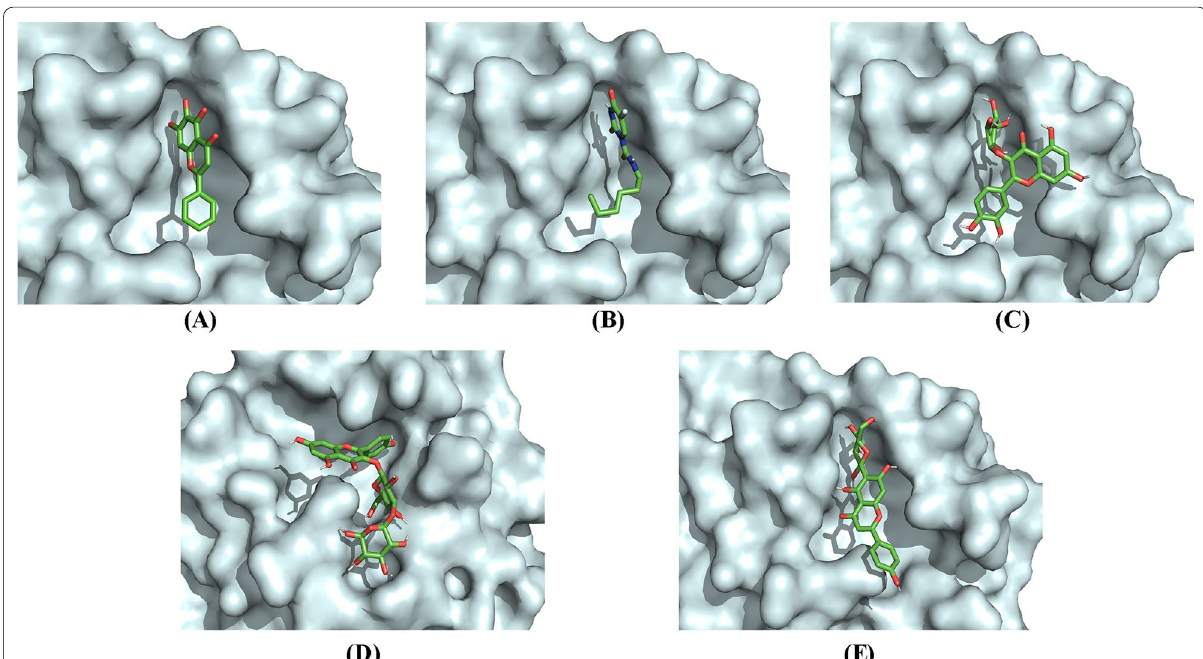
Fig. 5 3-dimensional view at the biding pose of ( a ) 3WL, ( b ) carmofur, ( c ) C_18, ( d ) C_4 and ( e ) C_5 at the active binding pockets of SARS-CoV-2 M pro